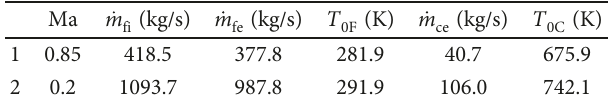
Table 2: BWB300 computation states.